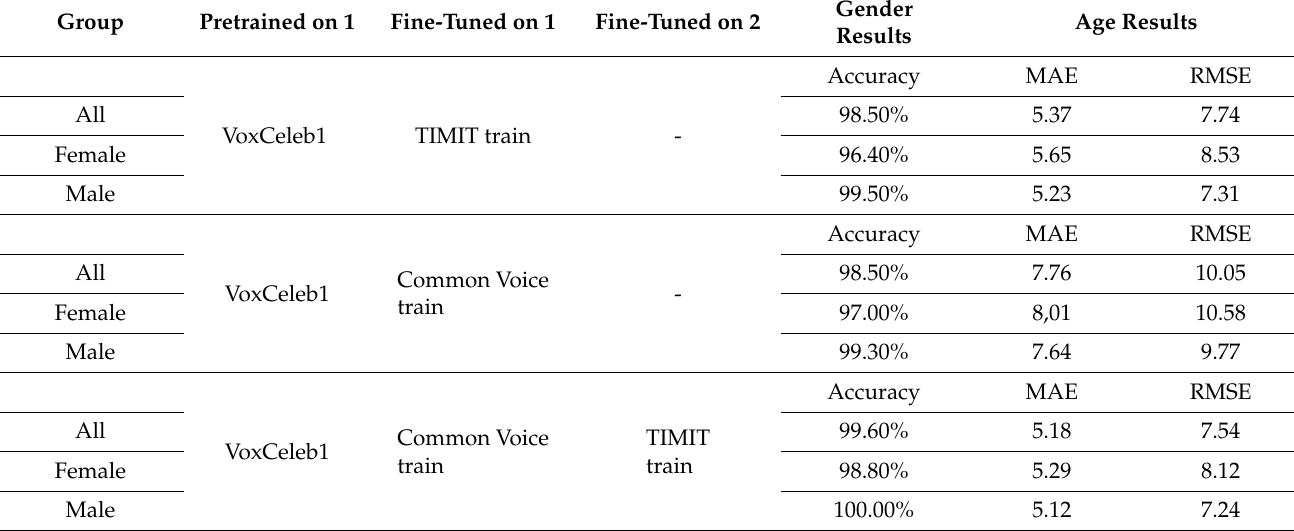
Table 12. Results on the TIMIT test dataset with a Quartznet-based x-vector embedder with dbFS normalization and additional embedder pre-training on the VoxCeleb 1